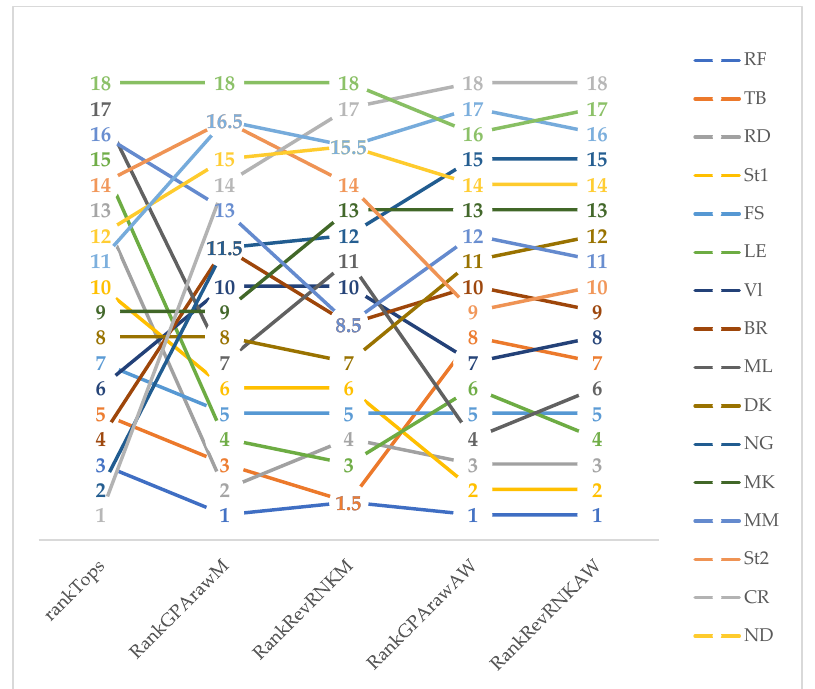
Figure 6. Comparison of TOPSIS, original and weighted SRD rankings along with the two coding schemes. rankTops—TOPSIS ranks, RankGPArawM—SRD ranks of original GPA coding with maximum reference, RankRevRNKM—SRD ranks of recoding to full rank with maximum reference, RankGPArawW—SRD ranks of original GPA coding with weighted reference, RankRevRNKW—SRD ranks of recoding to full rank with weighted